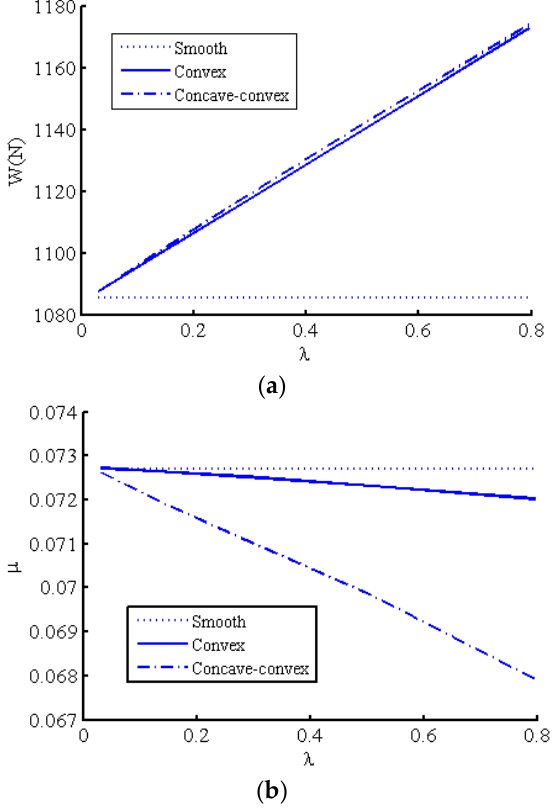
Figure 8. Effect of texture area density on ( a ) the load capacity and ( b ) the friction coefficient.